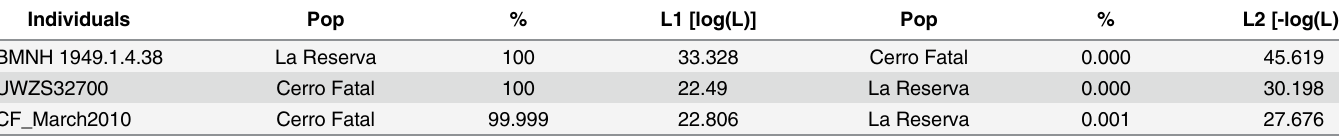
Table 4. Museum specimens assignment according to the microsatellite genotypic data and the test of GeneClass2 are indicated by their percent assignment (%) and corresponding likelihood values ( ‘ L1 ’ and ‘ L2 ’ ). Individuals Pop % L1